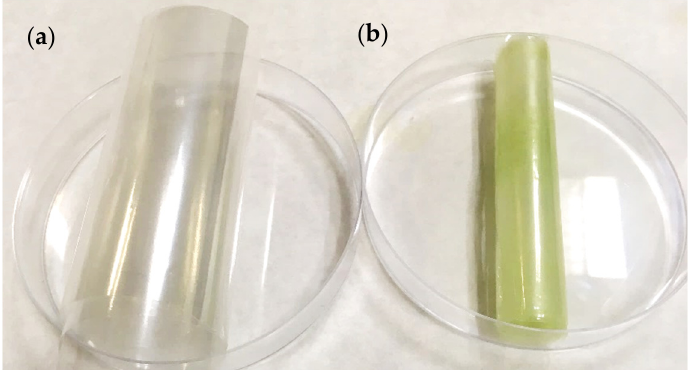
Figure 1. Appearance of the PET/PP films ( a ) before and ( b ) after OLE impregnation (sample corresponding to the impregnation at 400 bar and 35 °C by batch mode).